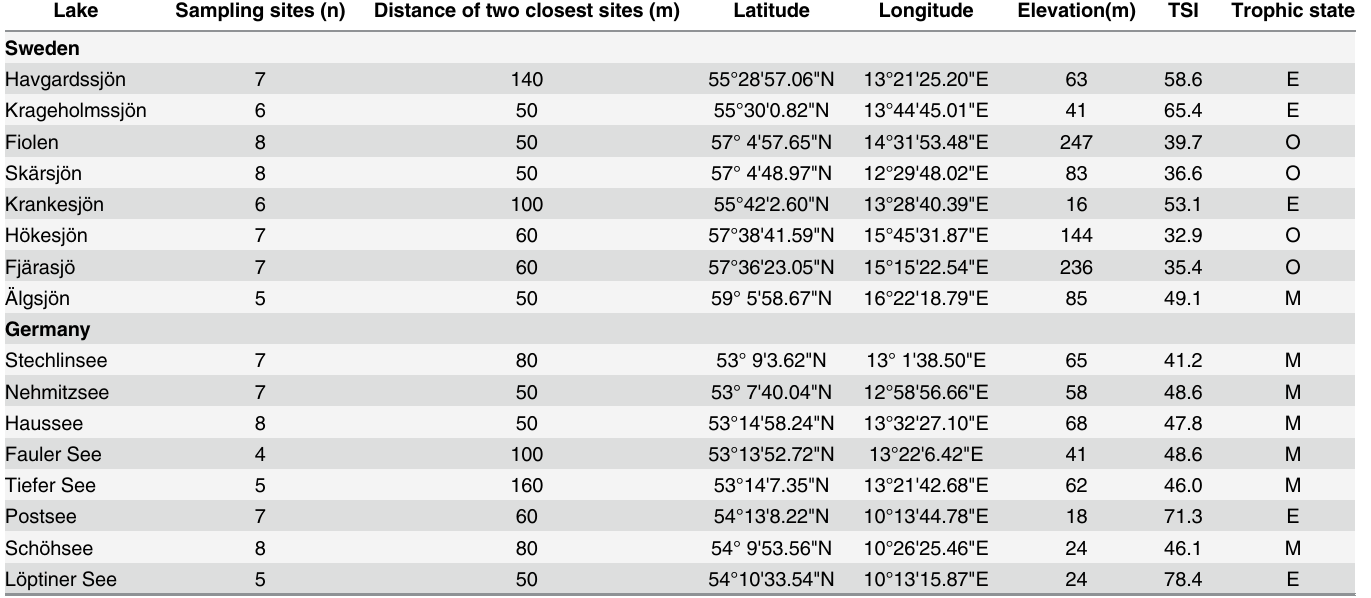
Table 1. Geographical and trophic data on the studied Swedish and German lakes. Trophic state index (TSI) was calculated according to the method of Carlson [37]. Data from a study of Ristau et al. [36] were supplemented by data on Lake Löptin (Löptiner See). Three replicates per sampling site. Lake Sampling sites